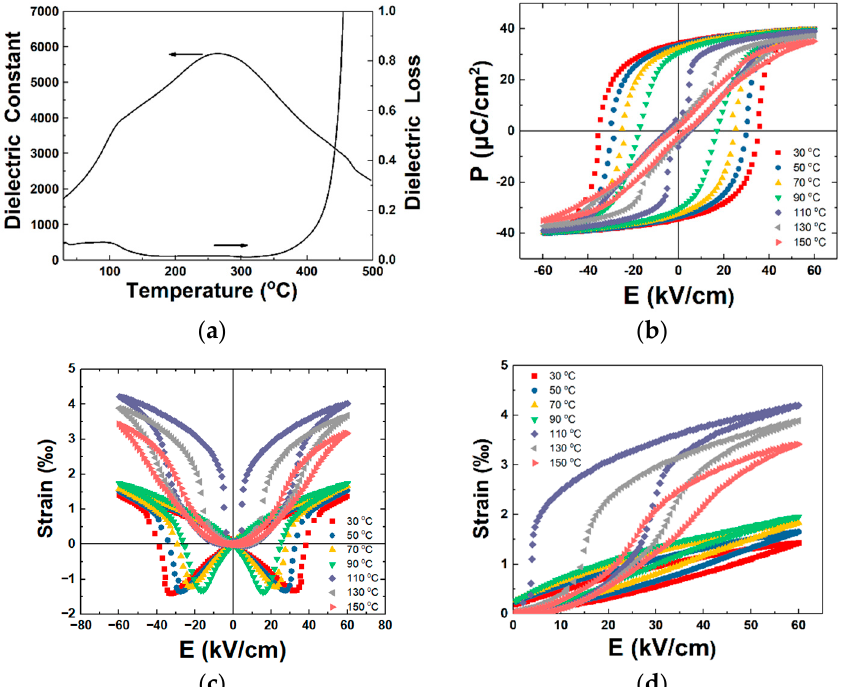
Figure 2. Temperature dependance: ( a ) dielectric constant and loss, ( b ) P-E hysteresis loops, ( c ) bipolar S-E hysteresis loops, ( d ) piezoelectric strains of BNT-6BT ceramics.